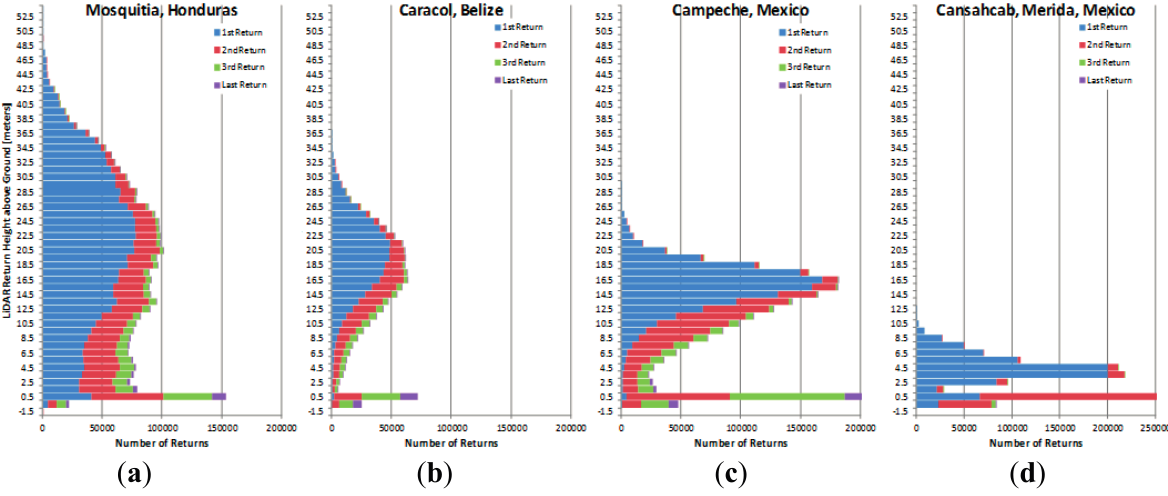
Figure 13. Canopy histograms that represent the detection of canopy returns at different elevation above the ground level of a 250 m × 250 m sample of different Mesoamerican forests. ( a ) La Mosquitia, Honduras; ( b ) Caracol, Central Belize; ( c ) Yaxnohcah , Campeche, Mexico; ( d ) Cansahcab, Campeche,